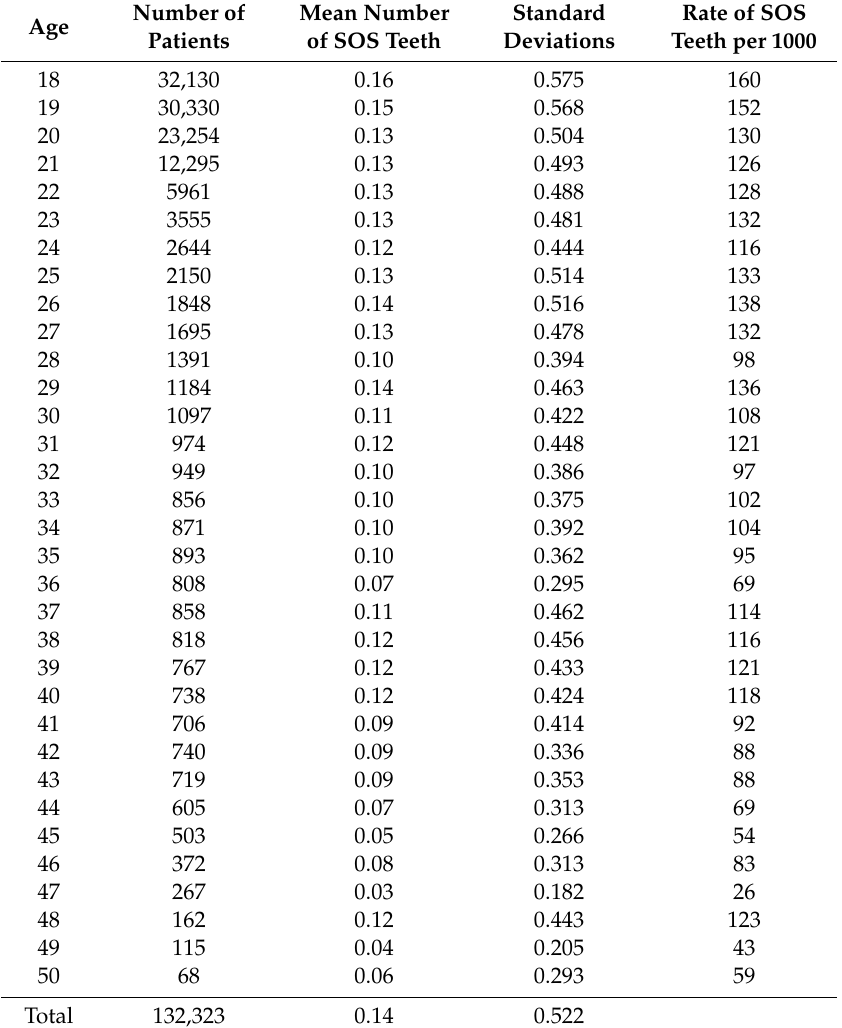
Table 3. Mean number of SOS teeth and the rate of SOS teeth per 1000 by